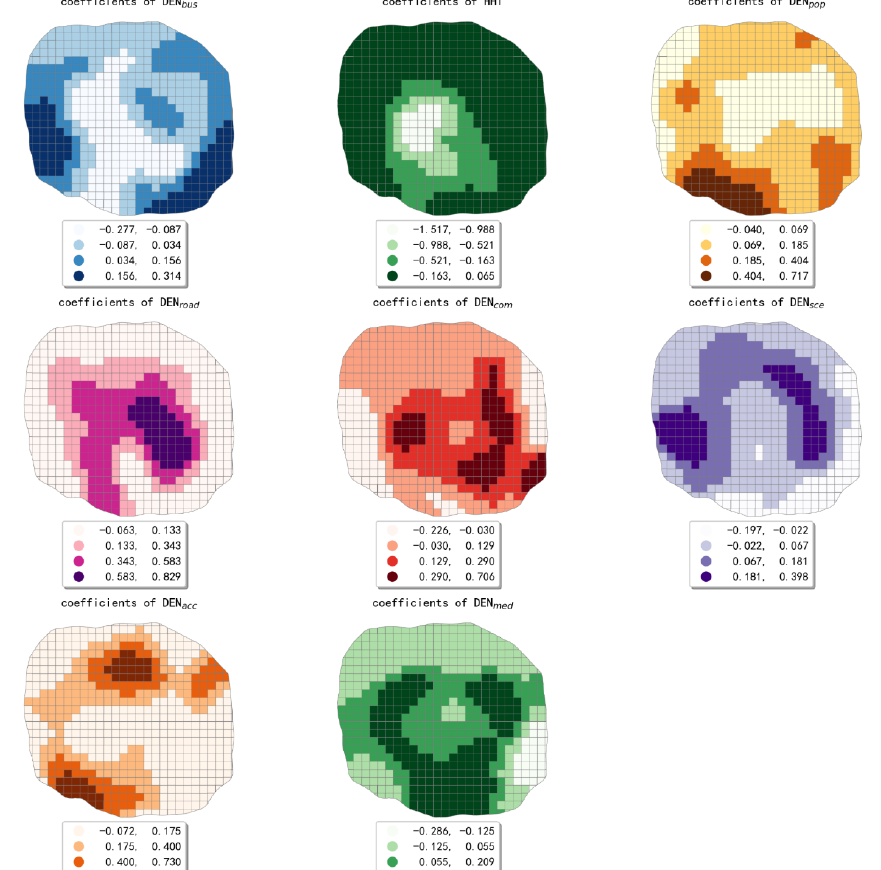
Figure 7. The map of coefficients estimated by the GWR model. The bus- stop density’s effect on taxis’ emissions showed an overall pattern that shifts from an inhibition effect in the central region to promotion effect in the peripheral region. In the central part of the study area and the areas along the northern part of the fourth ring road, the effect of bus-stop density on taxis ’ pollutant emissions was negative. Due to the high density of bus stops in this region, there was a competitive relationship be- tween bus and taxi that suppressed the traffic emissions from taxi trips. In the remaining areas along the fourth ring road, the effects of bus-stop density were mainly positive. It can be speculated that taxi travel is usually generated near the bus stations in this area, thus leading to an increase in taxis ’ pollutant emissions. Land-use mixture has a predominantly inhibitory effect on taxis ’ pollutant emissions, showing a circling pattern with a gradual decrease in inhibitory effect from the inside out. Except for the area along the western part of the fourth ring road, the effect of population density on taxis ’ pollutant emissions showed a general pattern of gradual increase from